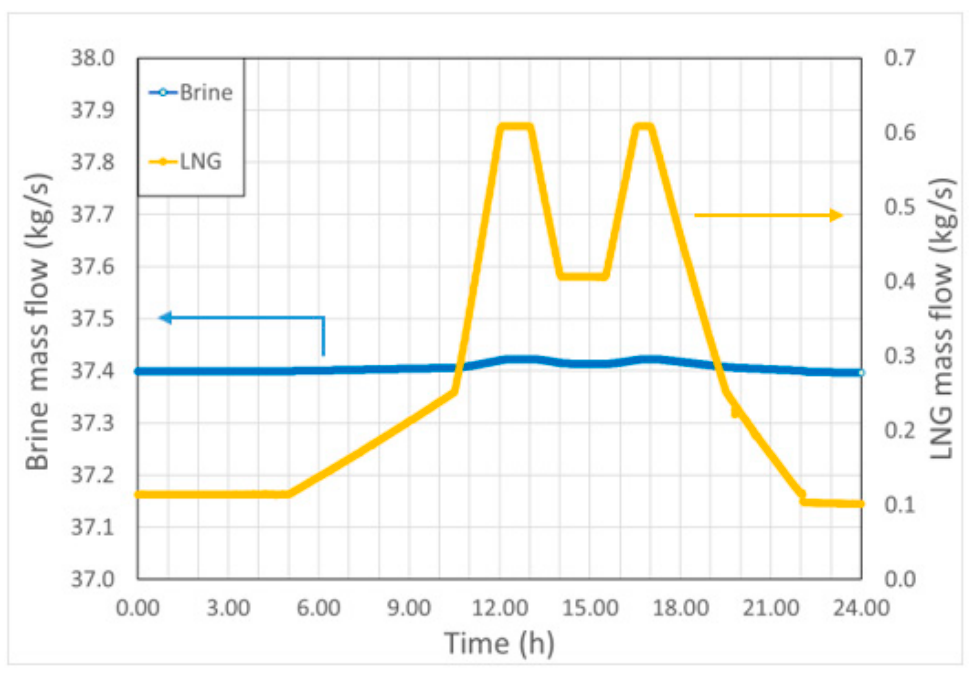
Figure 7. Trends of daily regasification and brine mass flow rates. The yellow curve refers to the secondary axis.